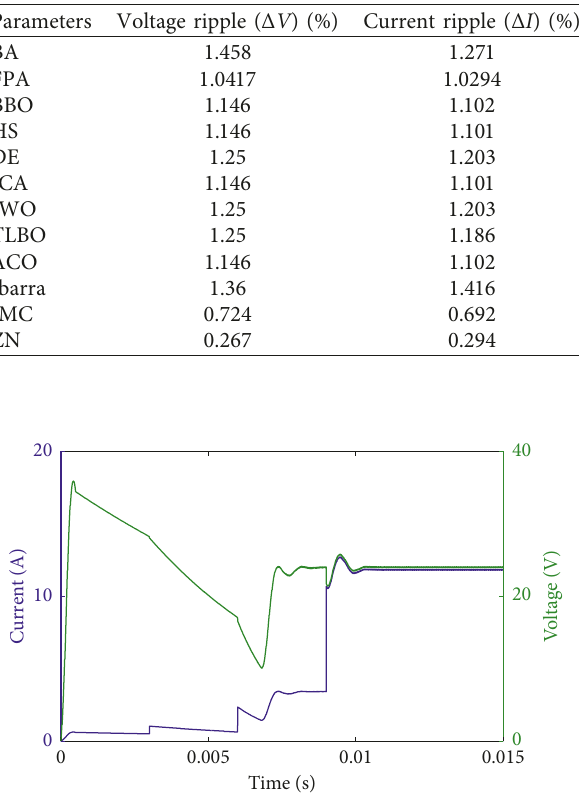
Figure 15: Plot for load current and voltage for varying load using Ziegler–Nichols-tuned PID controller.